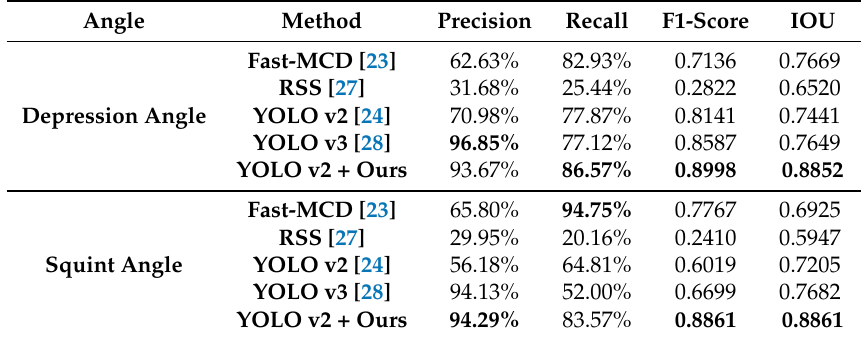
Table 3. Comparison of the detection performance of various methods in terms of Precision, Recall, F1-Score and